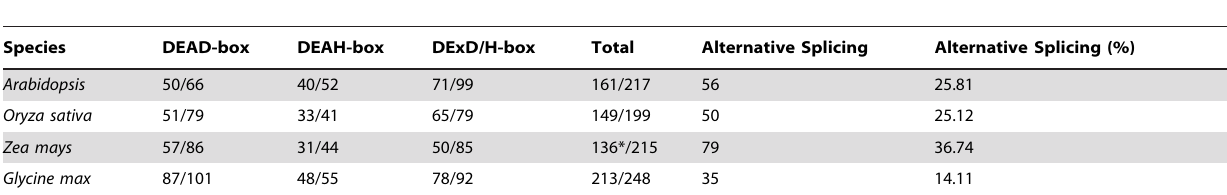
Table 1. The number of the DEAD-box, DEAH-box and DExD/H-box RNA helicase genes in Arabidopsis , Oryza sativa , Zea mays , Glycine max